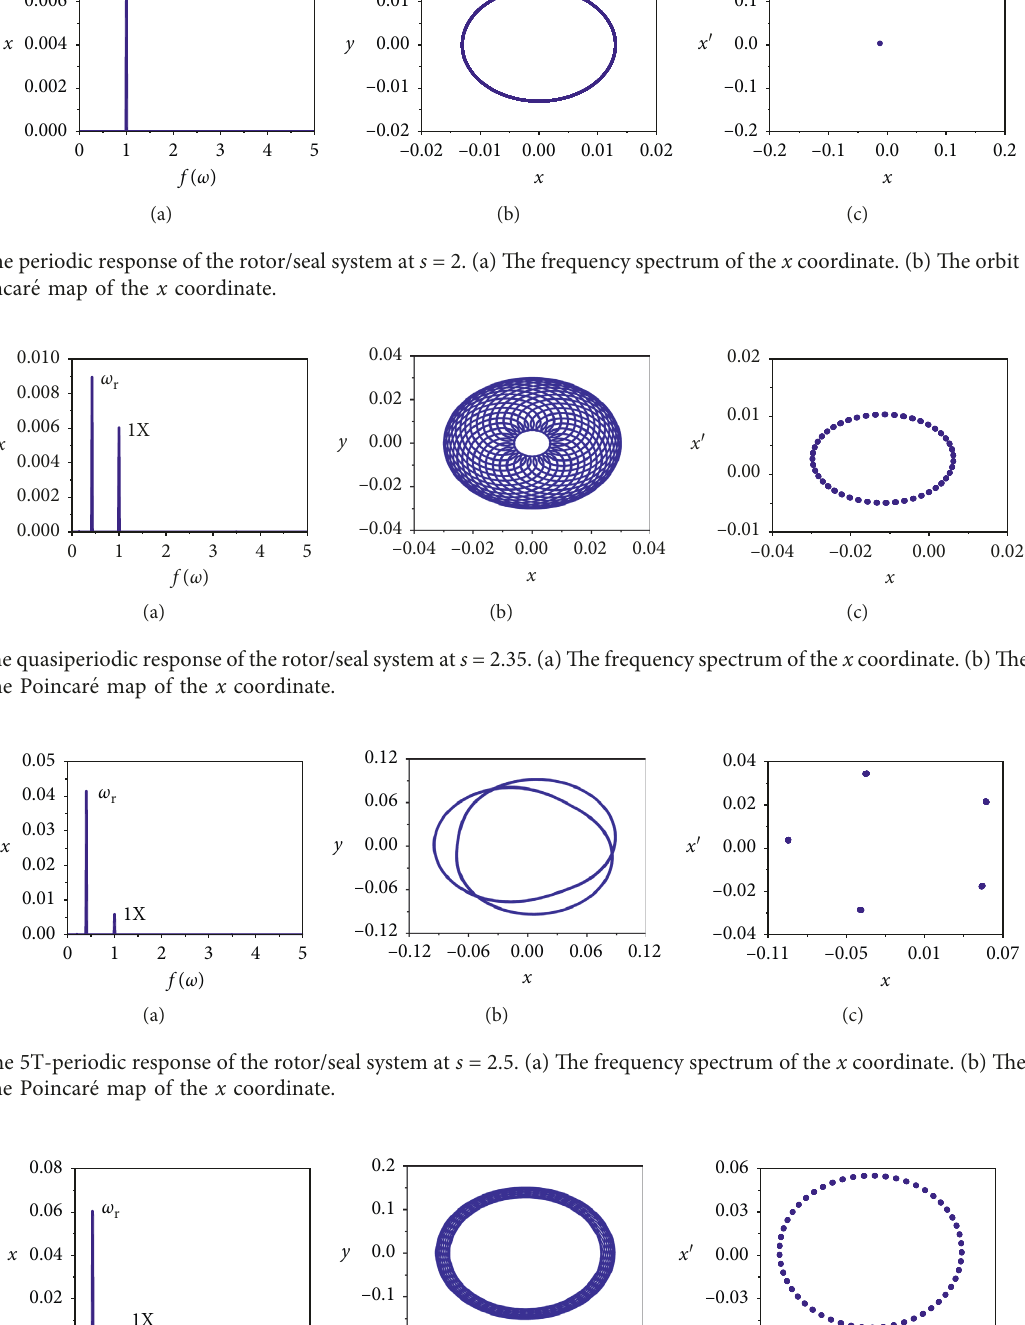
2.65. (a) The frequency spectrum of the x coordinate. (b) The orbit of the (cid:31)